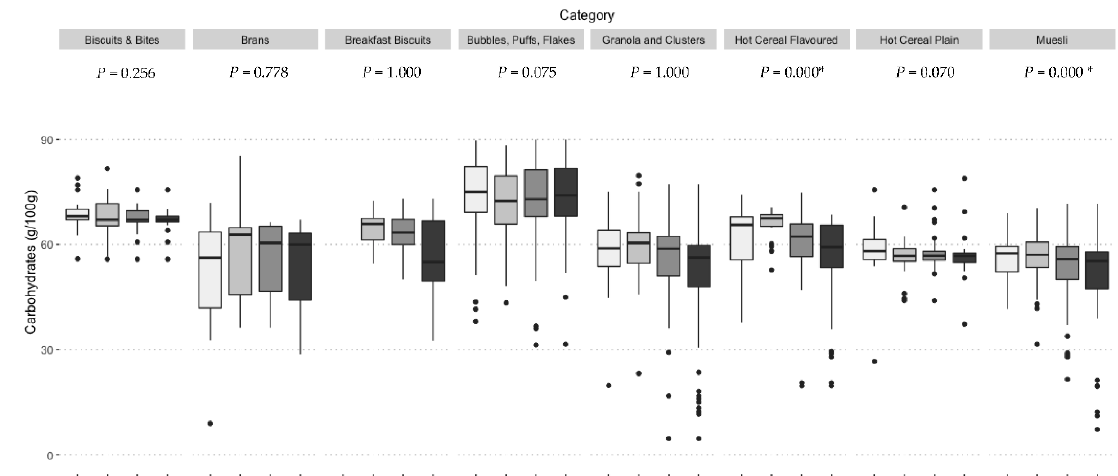
Figure A2. Carbohydrate content of breakfast cereals (g/100 g) between 2013, 2015, 2018, and 2020; p value comparing 2013 vs. 2020 (2015 vs. 2020 for breakfast biscuits). * Statistically significant p < 0.05.